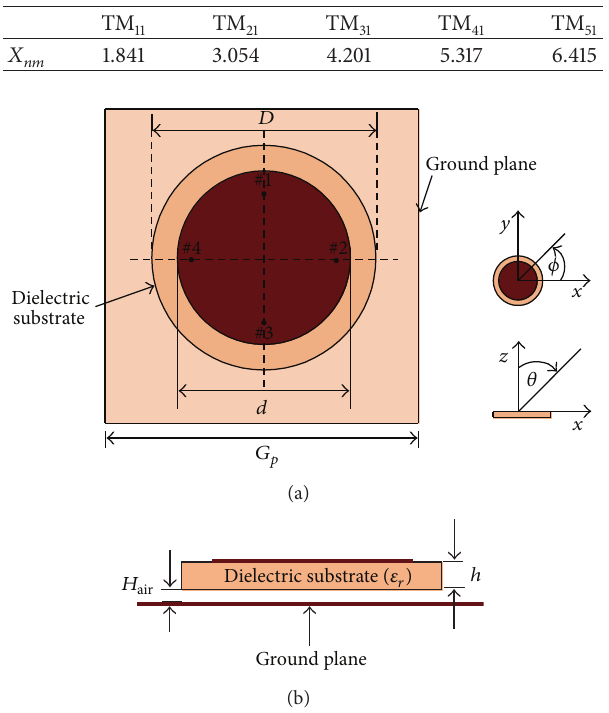
Table 1: Useful values of 𝑋 𝑛𝑚 .